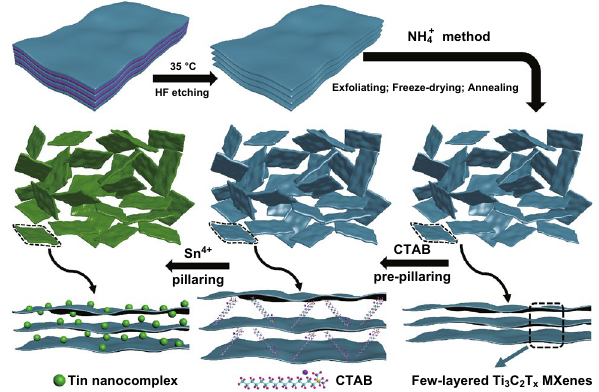
Fig. 1 Schematic illustration of the preparation procedure of Sn nanocomplex pillared few‑layered Ti 3 C 2 T x (STCT) composites by etching, sonication, pre‑pillaring, and pillaring processes